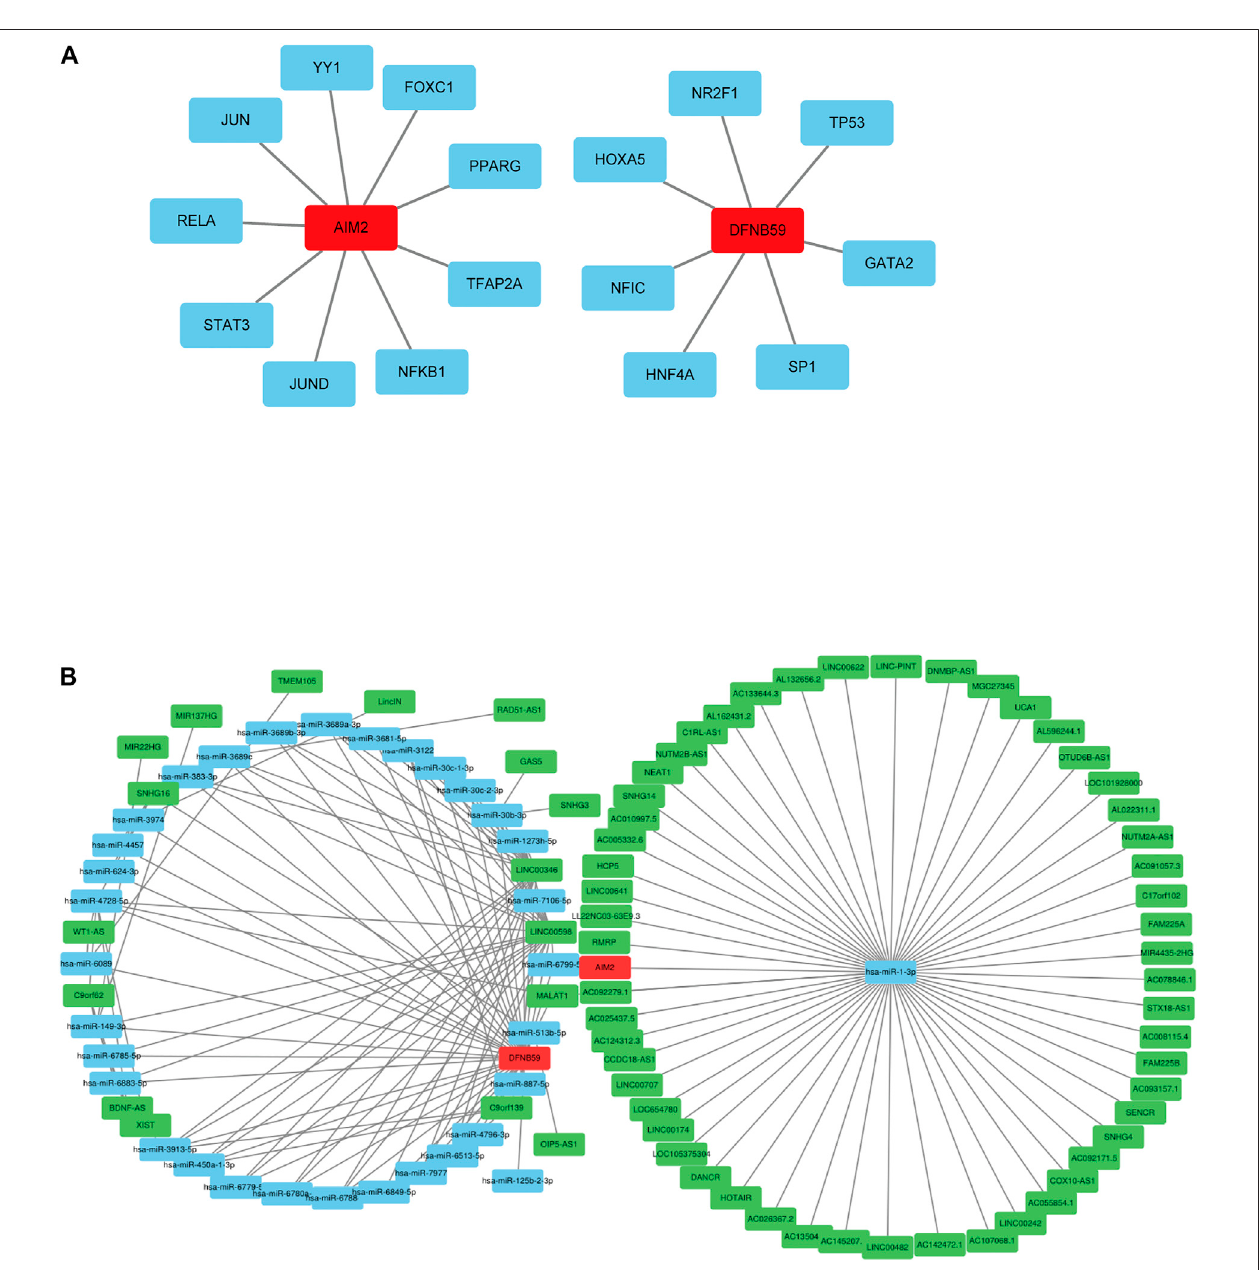
FIGURE 2 | Potential regulation of the independent prognostic PAGs. (A) Transcription factors of AIM2 and DFNB59. The red squares represent AIM2 and DFNB59, while thebluesquaresindicate theirtranscriptionfactors. (B) ThelncRNA-miRNA-mRNA (ceRNA)networkforAIM2 and DFNB59. Thegreen squares indicate lncRNAs, blue squares represent miRNAs and red squares depict